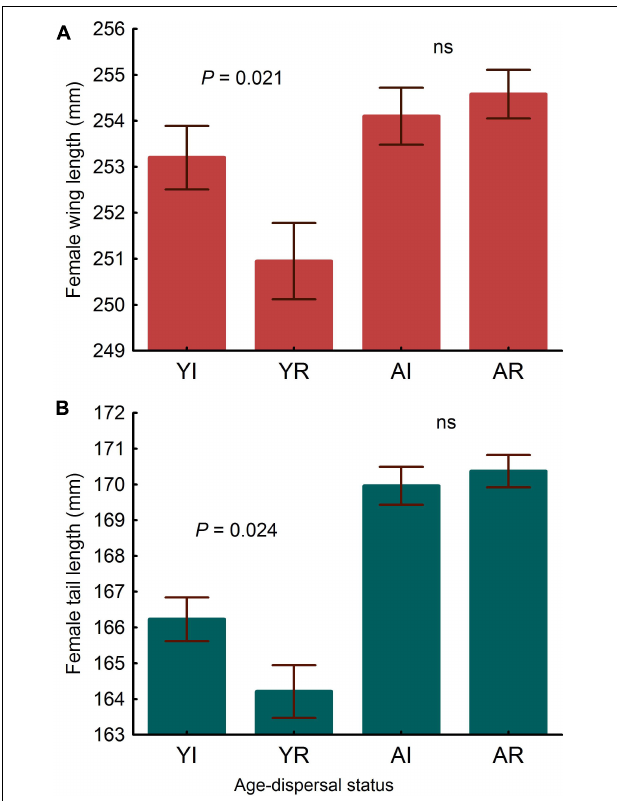
FIGURE 2 | Differences in wing (A) and tail (B) lengths corrected by body size (tarsus length) in breeding females. YI is young immigrant, YR is young resident, AI is adult immigrant and AR is adult resident. P -values correspond to post-hoc comparisons between groups from the interaction dispersal status x age in the LMMs. Values to the left and to the right correspond to differences in young and adults, respectively. “ns” means not significant differences (both P > 0.40). LMMs: wing length in young, estimate ± s.e. = 2.257 ± 0.97, t = 2.33; tail length in young,